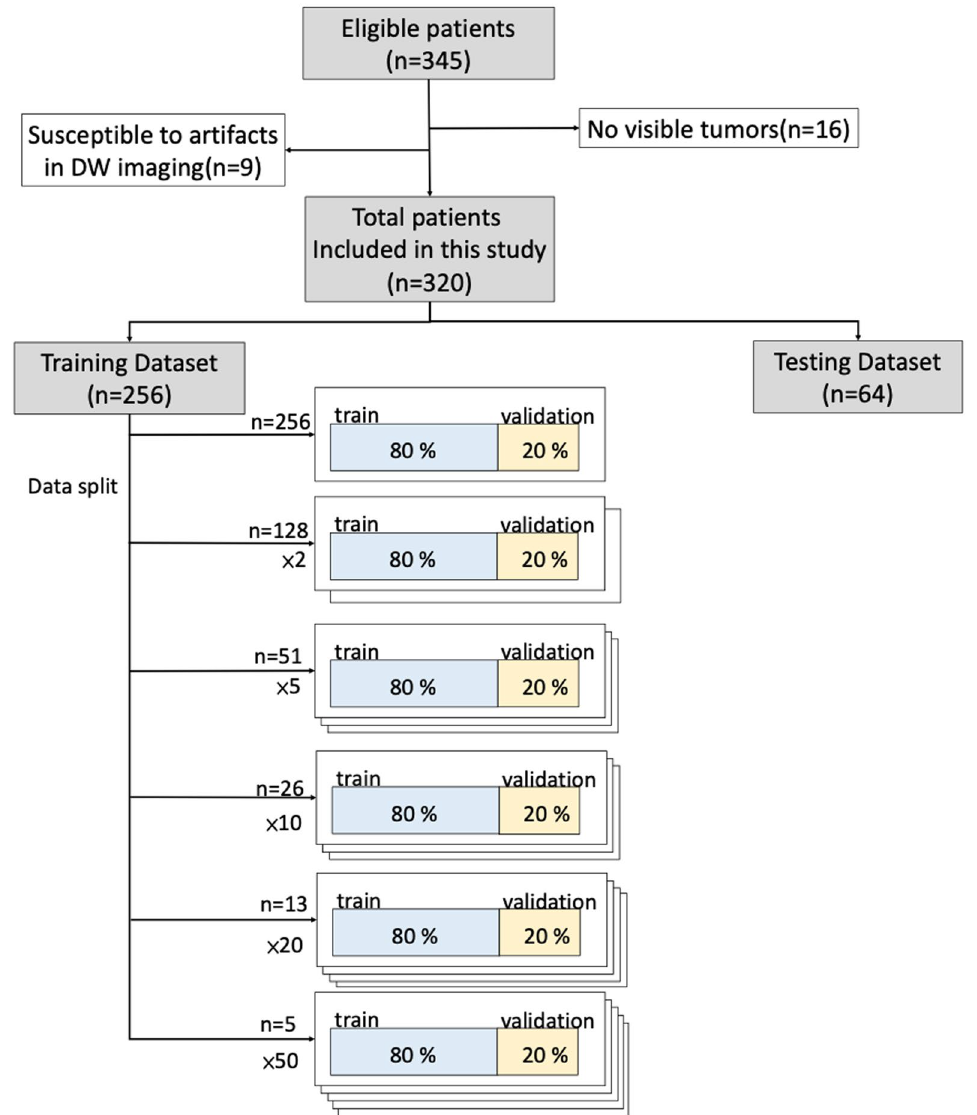
Fig. 2 Flowchart of uterine tumor dataset demonstrating data collection and split for various training